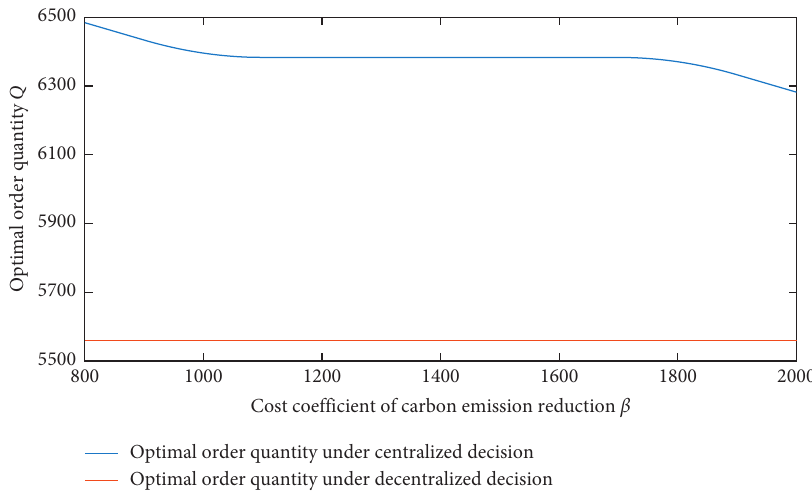
Figure 3: Effect of changes in manufacturers’ carbon reduction cost coefficient β on ordering volume under different decision-making conditions.